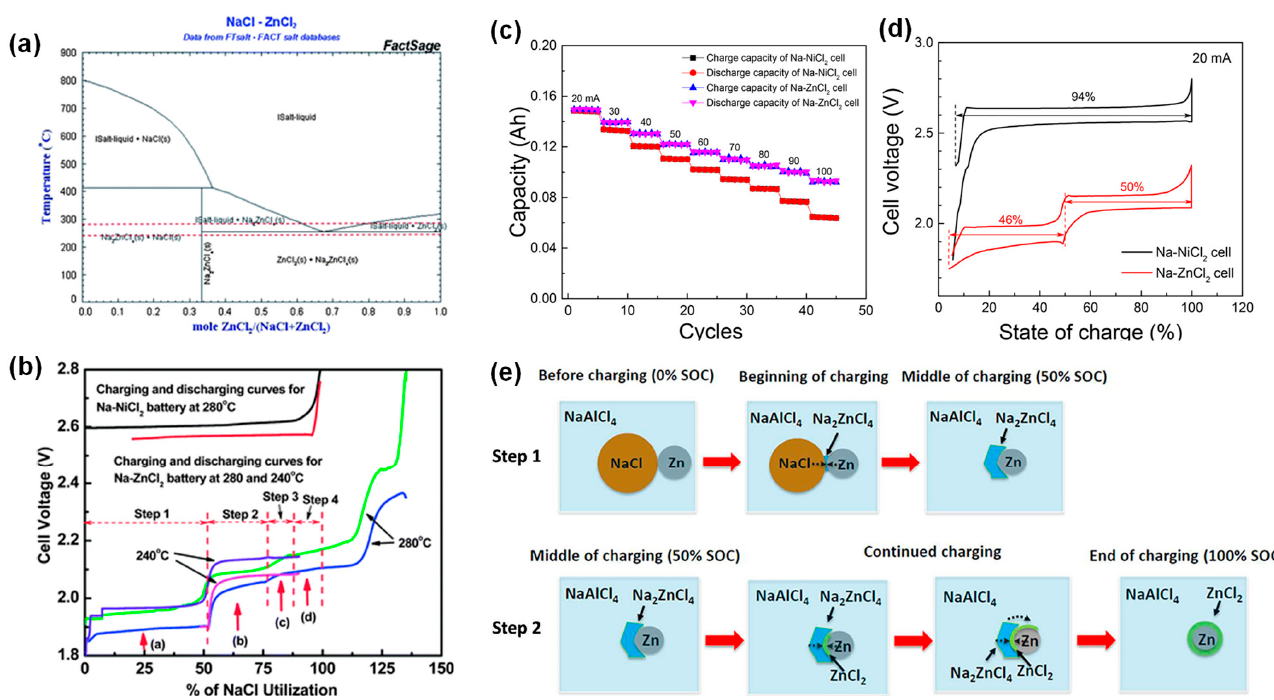
Figure 9. ( a ) Phase diagram between NaCl and ZnCl 2 . ( b ) Initial charge and discharge curves of a Na-ZnCl 2 battery at 280 °C and 240 °C compared with a Na-NiCl 2 battery (adapted with the permission from RSC). ( c ) Charge/discharge capacity of Na-ZnCl 2 and Na-NiCl 2 cells at different charging/discharging rates. ( d ) Voltage profiles of the two cells at constant currents of 20 mA. ( e ) Cathode reaction mechanisms for Na-ZnCl 2 battery (adapted with permission from ACS).